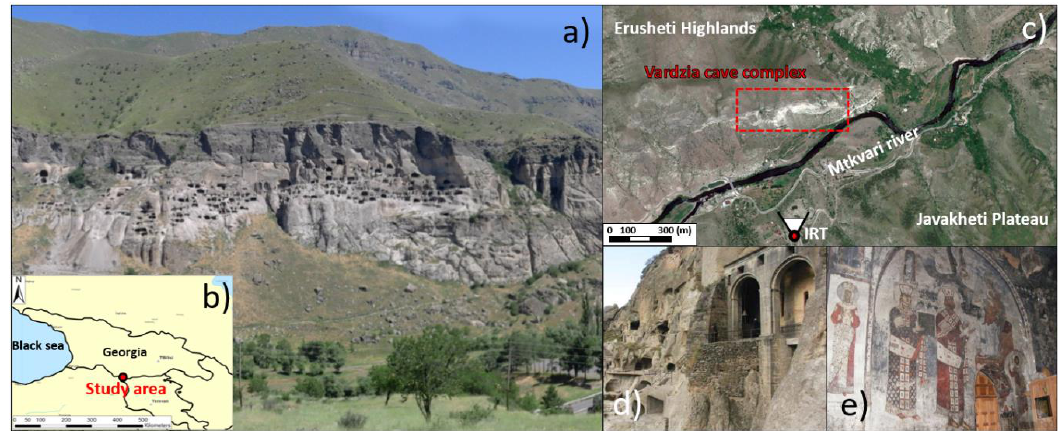
Figure 1. The rock‐cut city of Vardzia ( a ), Geographic location of the study area ( b ), the Mtkvari river valley and the Vardzia complex location, including InfraRed Thermography (IRT) camera installation point ( c ), the monastery complex: arched structures ( d ), frescoed chapels ( e ).